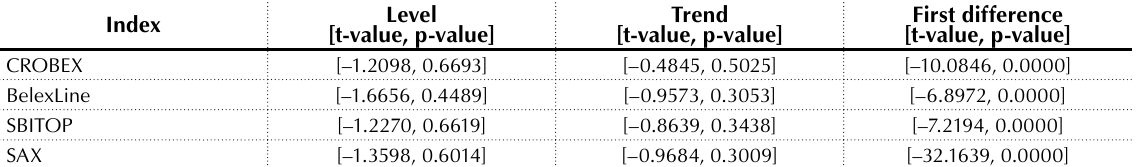
Table 2. ADF test results